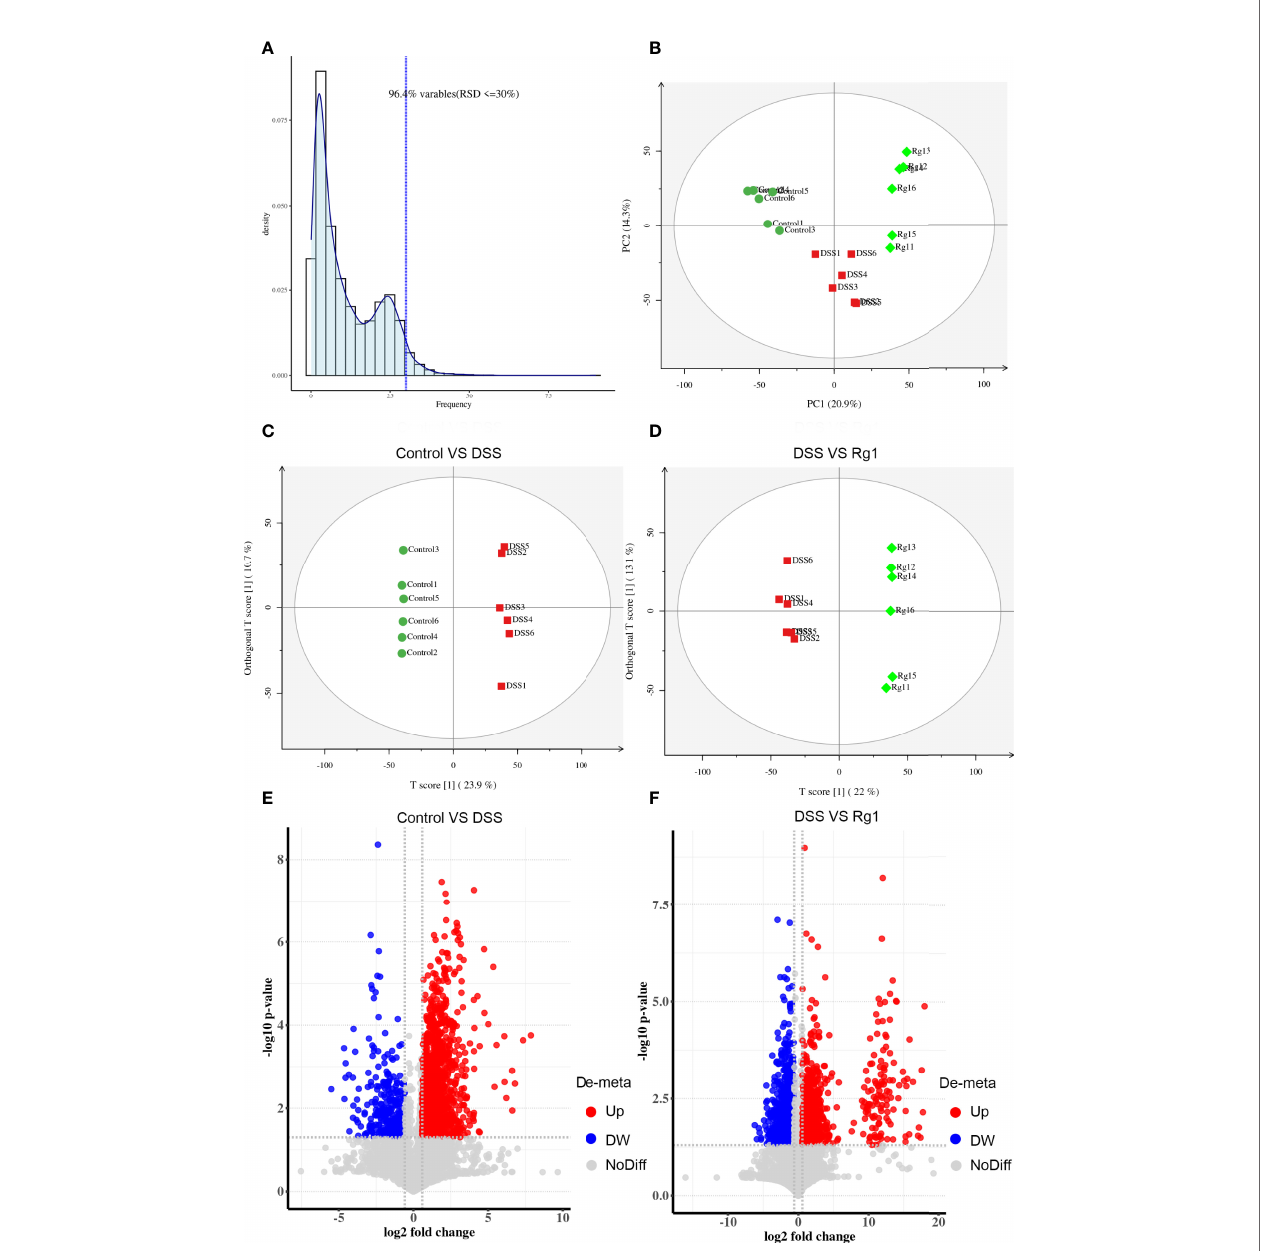
FIGURE 4 | Rg1 modulated the fecal metabolism in ESI positive ion mode. (A) QA analysis result shows the reliability of the data. (B) PCA score plots show that re fl ect the distribution of all samples. (C) OPLS-DA sore plot re fl ects the difference between the Control group and the DSS group. (D) OPLS-DA sore plot re fl ects the difference between the DSS group and the Rg1 group. (E) The volcano map re fl ects the different speci fi c metabolites between the Control group and the DSS group. (F) The volcano map re fl ects the different speci fi c metabolites between the DSS group and the Rg1